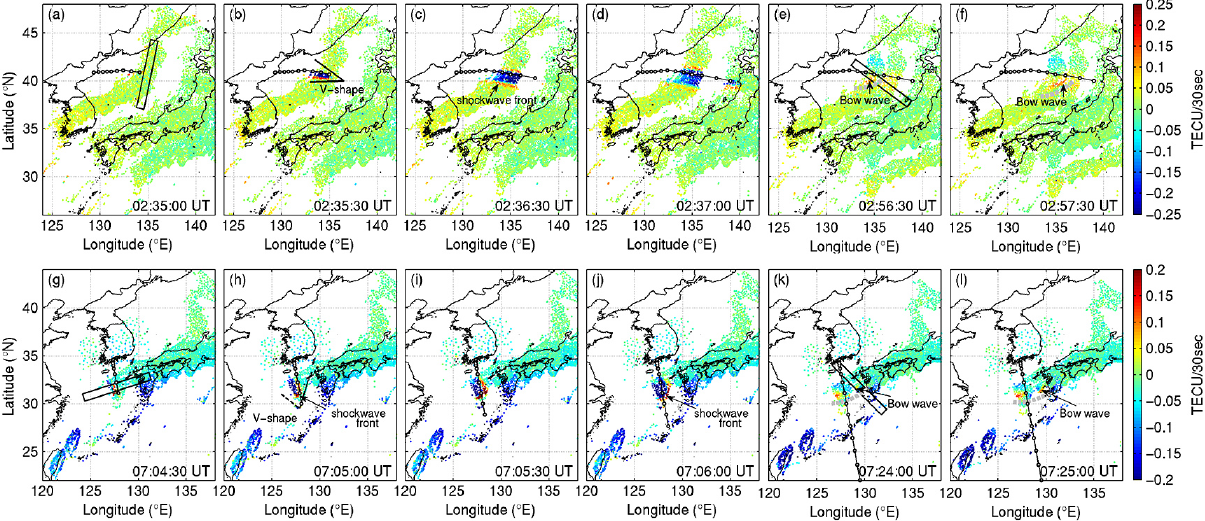
Figure 1. Snap shots of the rate of change of TEC (rTEC) indicating the shock and bow waves (enhanced rTECs in red color) and ionospheric depletions resulting from the rocket exhaust of the 2009 North Korea Taepodong-2 (a – f) and 2013 South Korea KSLV-II (g – l) rocket launches. The square boxes plotted in panels (a) , (e) , (g) , (k) identify the regions for calculating the wave velocities shown in Figs. 4a and b, and 5a and c,